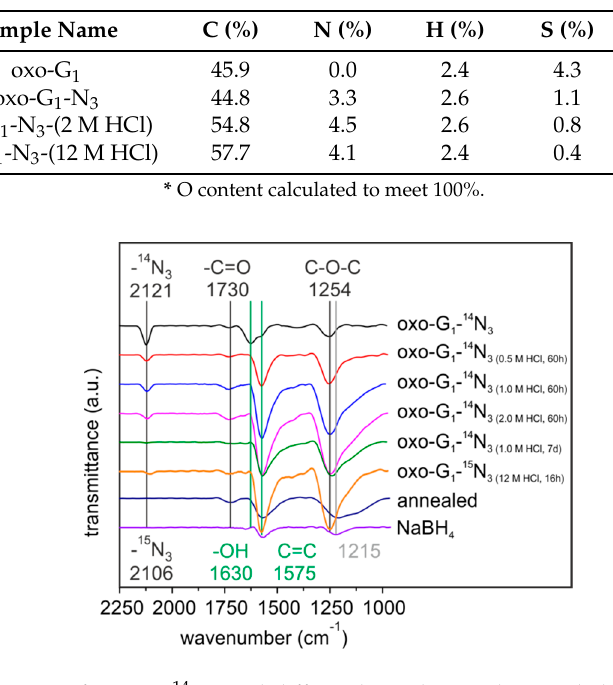
Figure 1. FTIR spectra of oxo-G 1 - 14 N 3 and differently HCl-treated, annealed (140 °C) and sodium boron hydride reduced samples of oxo-G 1 - 14 N 3 .